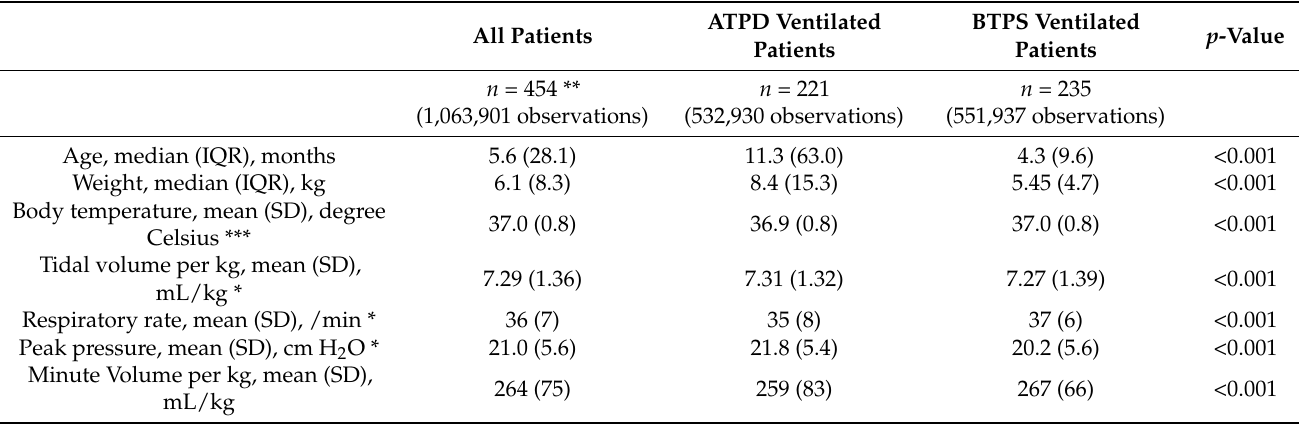
Table 1. Differences between ATPD ventilated patients and BTPS ventilated patients. All Patients